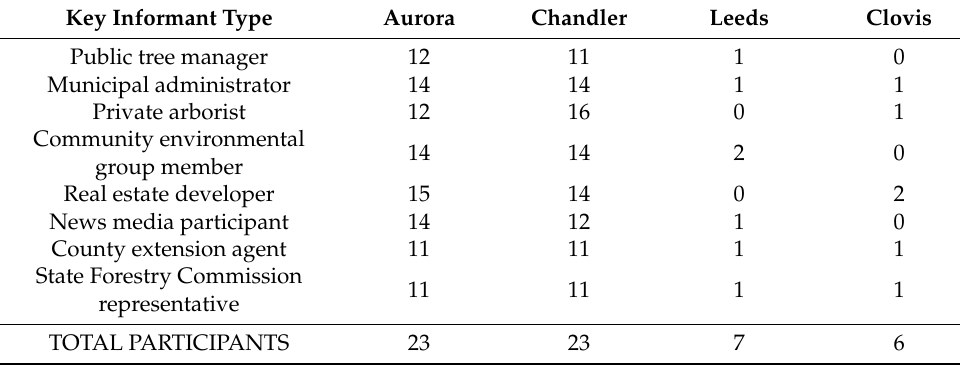
Table 2. Participating key informants by study site and participant group (key informant type). Key Informant